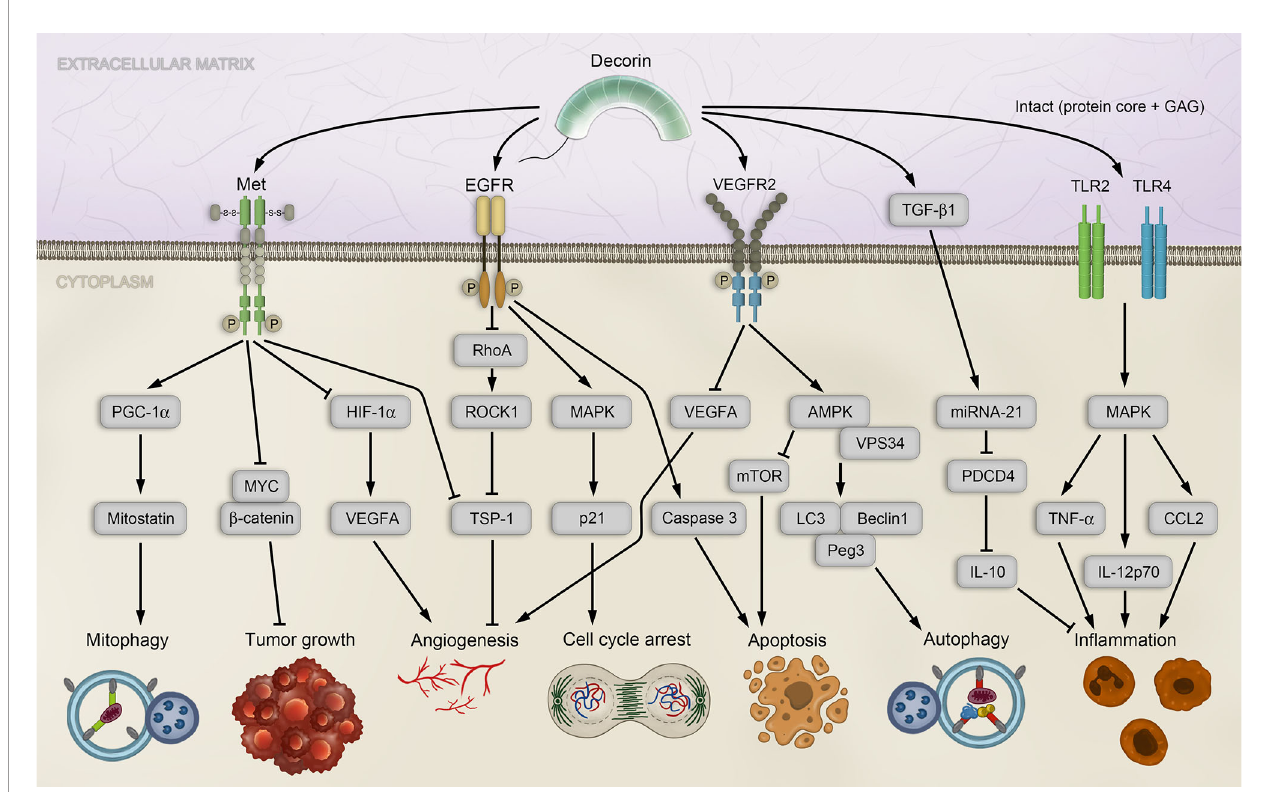
FIGURE 1 | Decorin-mediated signaling affects diverse pathways associated with tumorigenesis. Decorin activates mitophagy in breast carcinoma cells by binding to the Met receptor and activating PGC-1 a , leading to accumulation of Mitostatin. Further, via Met receptor signaling, decorin inhibits tumor growth by down-regulating b -catenin and MYC, and inhibiting angiogenesis by repressing HIF-1 a and VEGFA. Angiogenesis is also modulated by decorin through EGFR in a signaling cascade that employs Rho and ROCK1, leading to upregulation of the anti-angiogenic effector TSP-1. EGFR phosphorylation by decorin induces intracellular MAPK, resulting in enhanced expression of p21 and cell cycle arrest, and in release of Caspase 3 and apoptosis. Decorin-mediated VEGFR2 signaling inhibits angiogenesis and induces autophagy in endothelial cells by inhibiting mTOR, activating VPS34, Beclin-1, LC3 and Peg3. Decorin regulates in fl ammation in a PDCD4-dependent manner through miRNA-21, or by TLR2/4 signaling. AMPK, AMP-activated protein kinase; CCL, chemokine C – C motif-ligand; EGFR, epidermal growth factor receptor; GAG, glycosaminoglycan; HIF-1 a , hypoxia-inducible factor 1 a ; IL, interleukin; LC3, microtubule-associated protein 1A/1B-light chain 3; MAPK, mitogen- activated protein kinase; Met, mesenchymal-epithelial transition factor; miRNA, microRNA; mTOR, mammalian target of rapamycin; MYC, myelocytomatosis oncogene protein; PDCD4, programmed cell death protein 4; Peg3, paternally expressed 3; PGC-1 a , peroxisome proliferator-activated receptor- g co-activator 1- a ; Rho, RAS homolog family member A; ROCK1, Rho-associated coiled-coil kinase 1; TGF- b 1, transforming growth factor b isoform 1; TLR, Toll-like receptor; TNF- a , tumor necrosis factor alpha; TSP-1, thrombospondin-1; VEGFA, vascular endothelial growth factor A; VEGFR2, vascular endothelial growth factor receptor 2; VPS34, vacuolar protein sorting